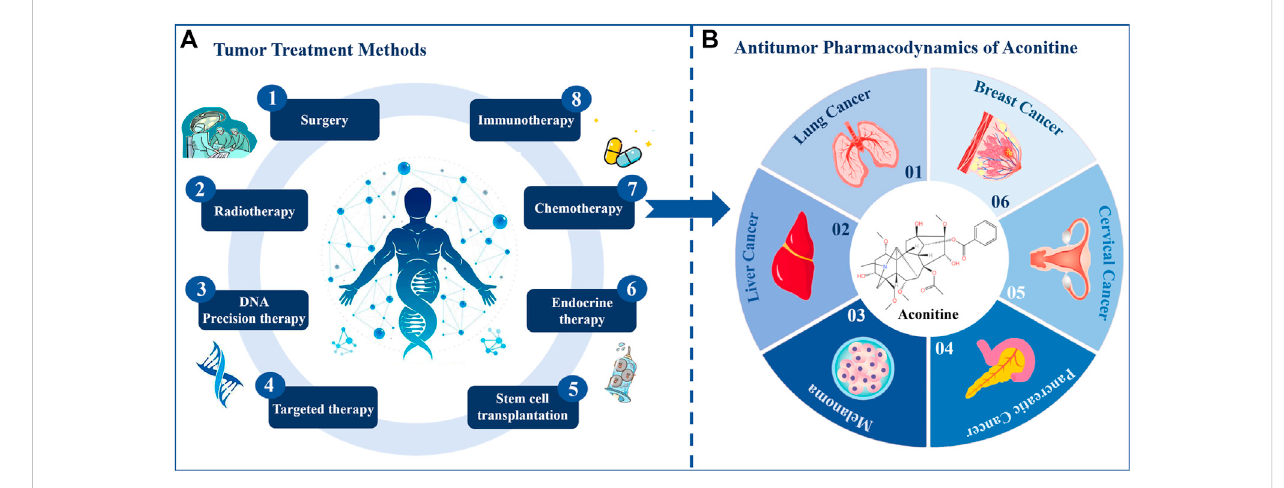
FIGURE 1 The main method of tumor treatment. (A) Tumor treatment methods. (B) Antitumor pharmacodynamics of aconitine.